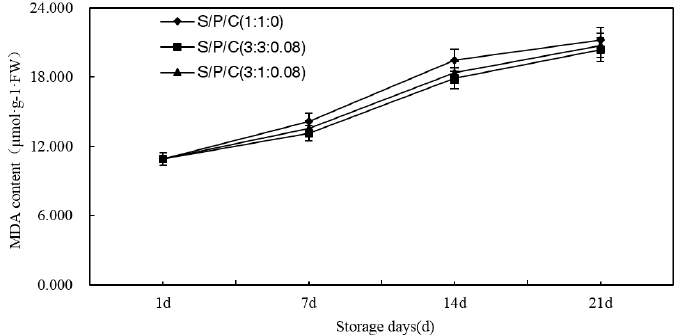
Figure 11. Effect of starch/polyvinyl alcohol/citric acid ternary blend functional food packaging films on the content of MDA.